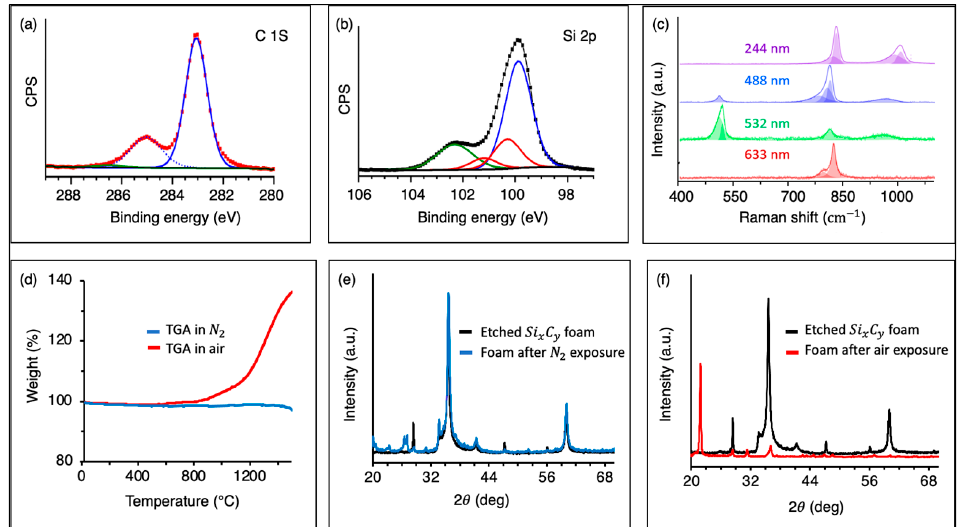
Figure 4. ( a , b ) XPS surface survey spectrums from C1s and Si 2p signals, respectively; ( c ) Raman results using different excitation energies; ( d ) TGA of the foam in nitrogen and air atmospheres; ( e , f ) XRD results of the foam overlapped with results after TGA experiments.